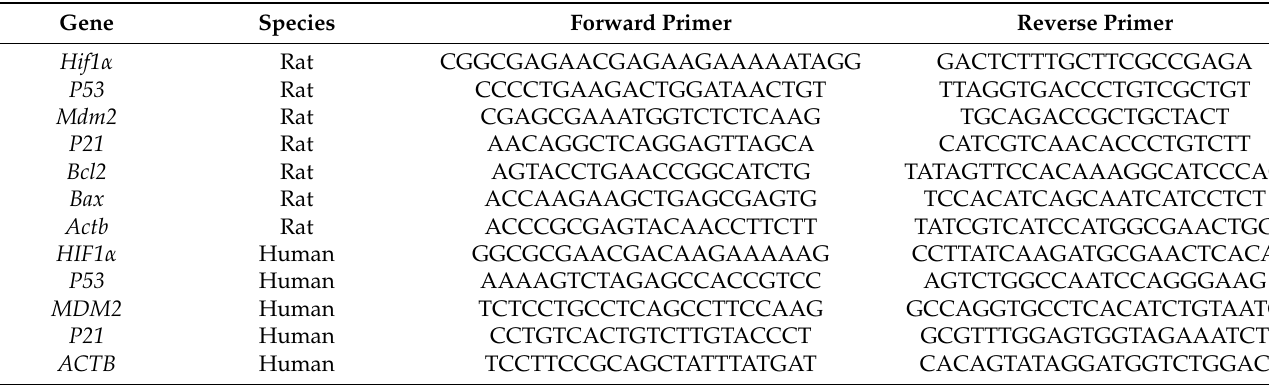
Table 1. Nucleotide sequences of the forward and reverse primers for